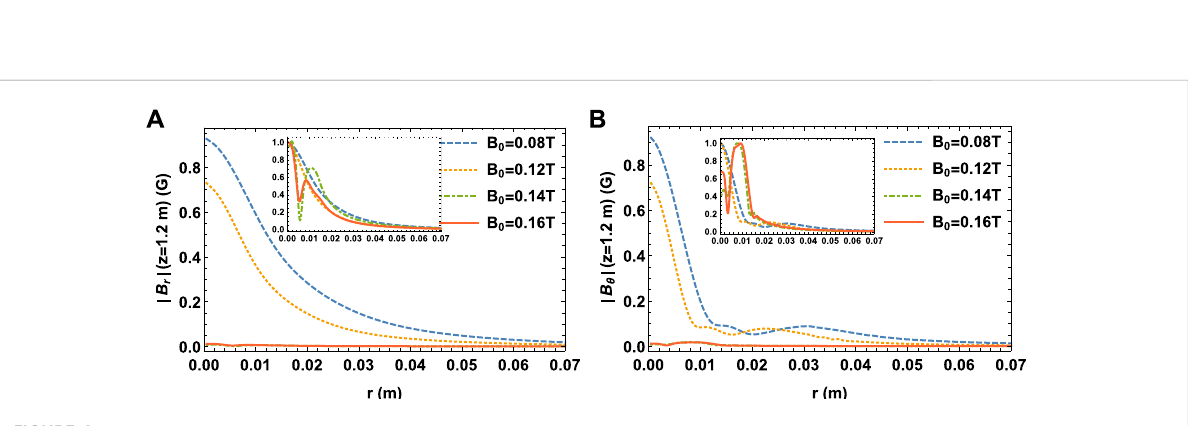
FIGURE 4 Radial pro fi les of wave magnetic fi eld (A) , radial component; (B) , azimuthal component for four external magnetic fi eld strengths, measured at z = 1.2 m ( P 1 ). The inset shows normalised